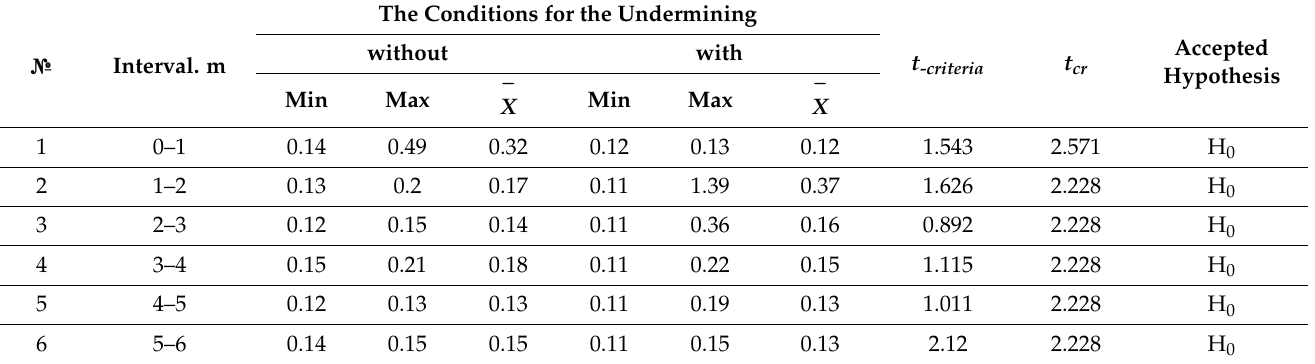
Table 1. The results of the statistical analysis of the experimental studies of the gas content of the drift